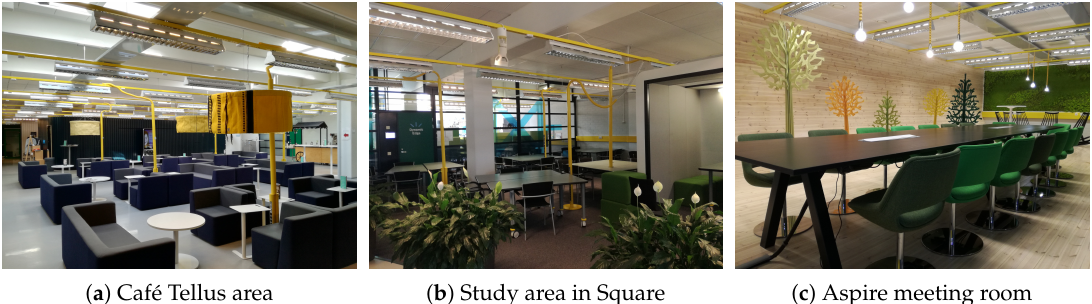
Figure 1. Tellus Innovation Arena (Tellus)